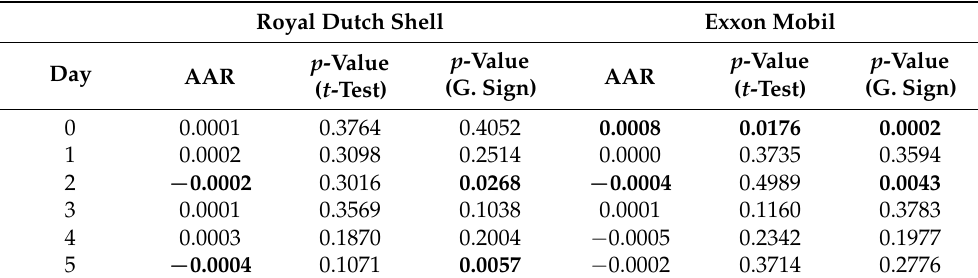
Table 5. Average abnormal returns Royal Dutch Shell and Exxon Mobil—Induced seismicity in Anadarko Basin ( df =